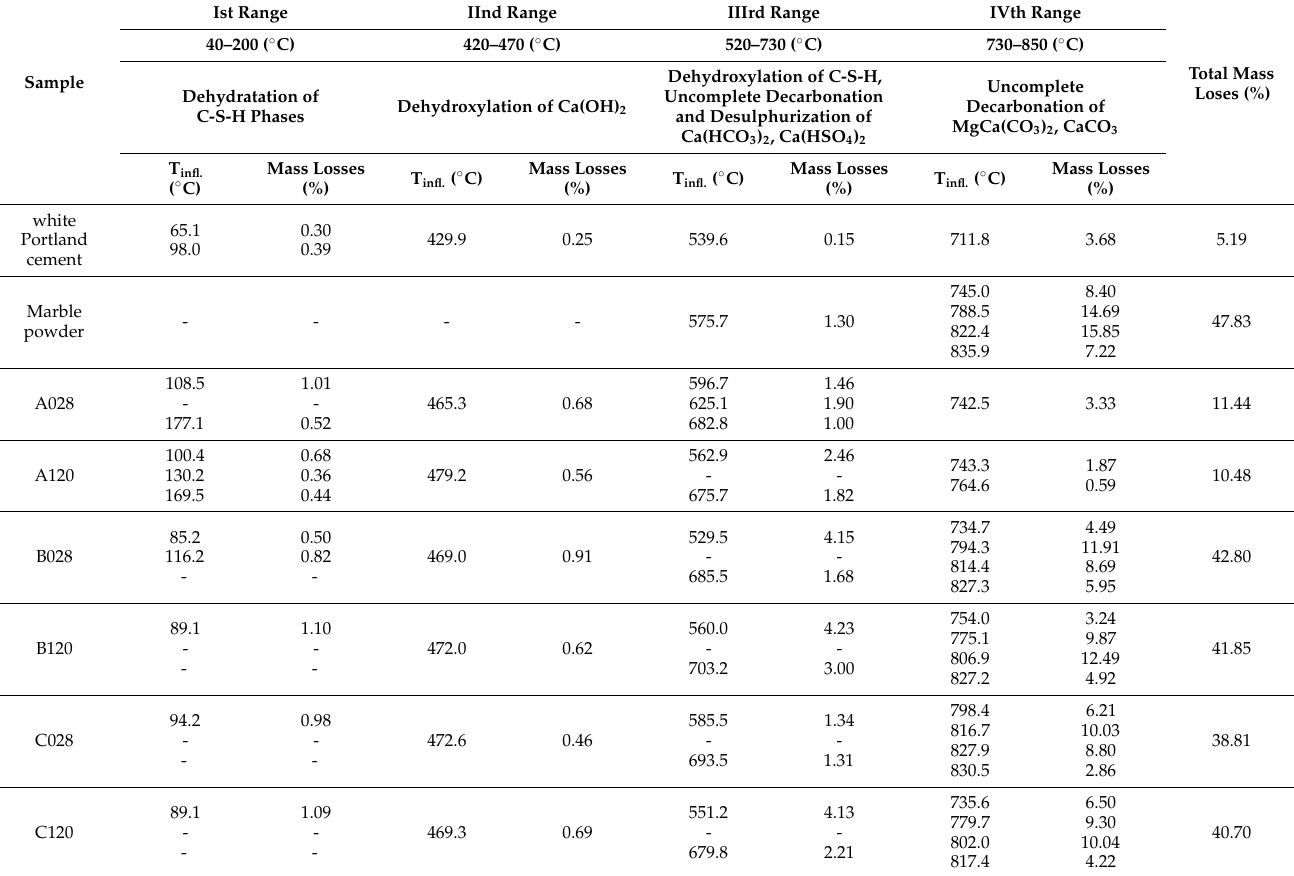
Table 6. Thermal decomposition (T infl. ) and ML of the raw materials and